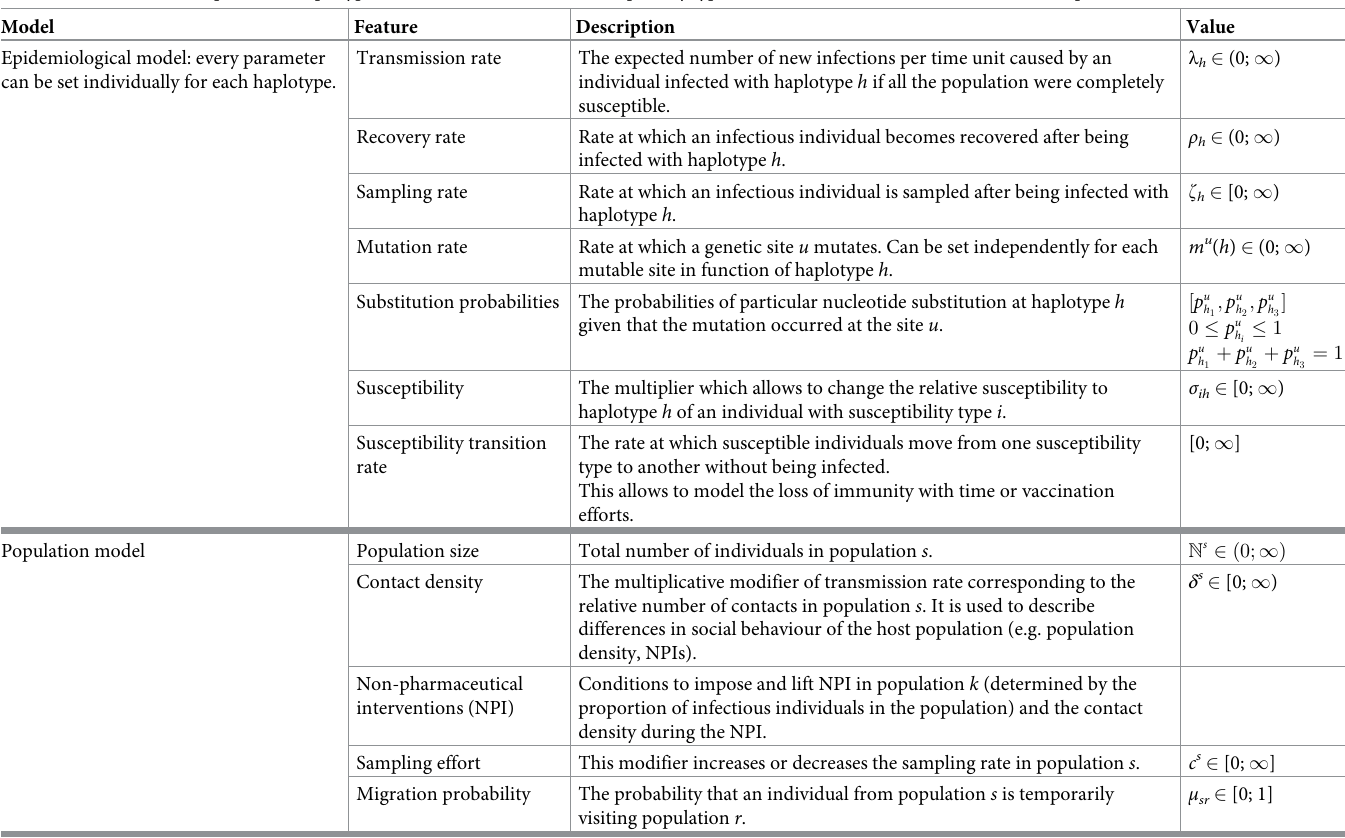
λ h 2 (0; 1 ) ρ h 2 (0; 1 ) m u ( h ) 2 (0; 1